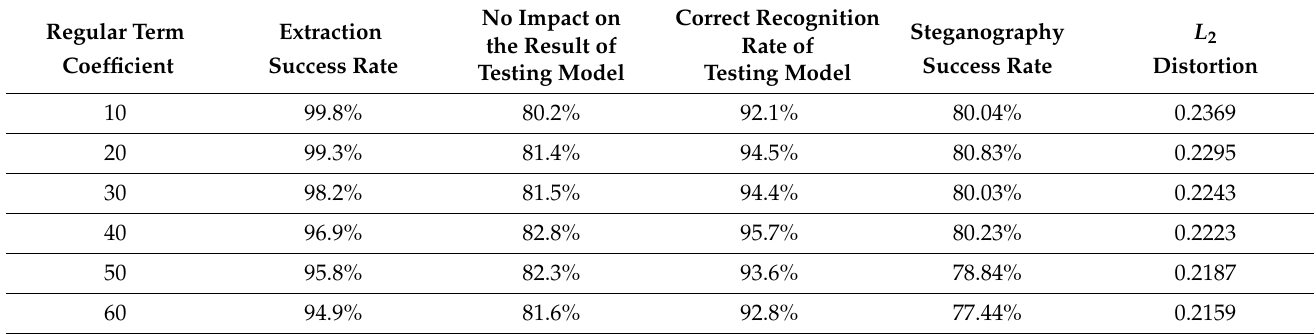
Table 2. Statistics of the variation of extraction success rate, the correct recognition rate of the testing model, probability of no effect on the testing model, steganography success rate, L 2 distortion with regular term